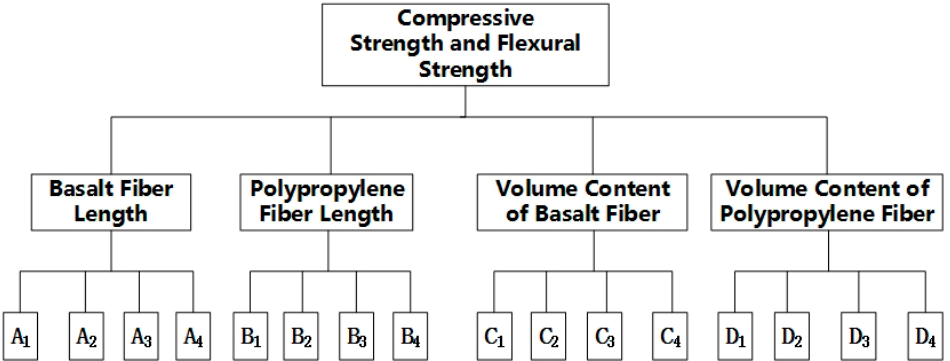
Figure 3. Orthogonal test Analytic Hierarchy Process (AHP) mode.